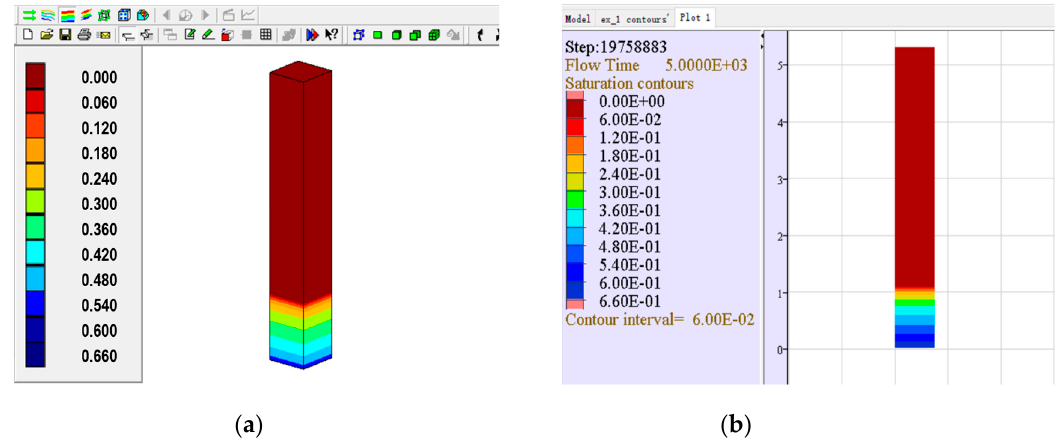
Figure 6. Contrast of simulated water saturation distribution after 5000s: ( a ) Instantaneous water saturation distribution calculated by self-developed source codes; and ( b ) instantaneous water saturation distribution calculated by FLAC.